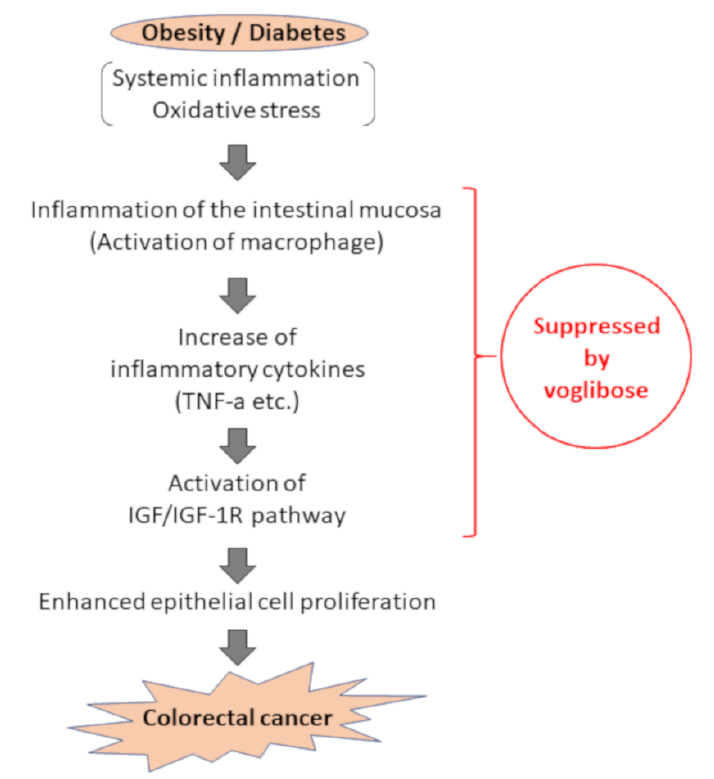
Figure 7. Assumed mechanism of inhibitory effect of voglibose on colorectal carcinogenesis due to obesity and diabetes pathology. In the pathology of obesity/diabetes, inflammation in the intestinal mucosa is formed by activation of inflammatory cells, including macrophages, against the background of systemic and chronic inflammation and oxidative stress, and an increase of inflammatory cytokines such as TNF-α. Accordingly, activation of the IGF/IGF-1R signaling pathway occurs, and cell proliferation of intestinal mucosal epithelial cells is enhanced, leading to carcinogenesis. This study suggests that voglibose can suppress colorectal carcinogenesis through suppression of intestinal inflammation and IGF/IGF-1R signaling pathway.